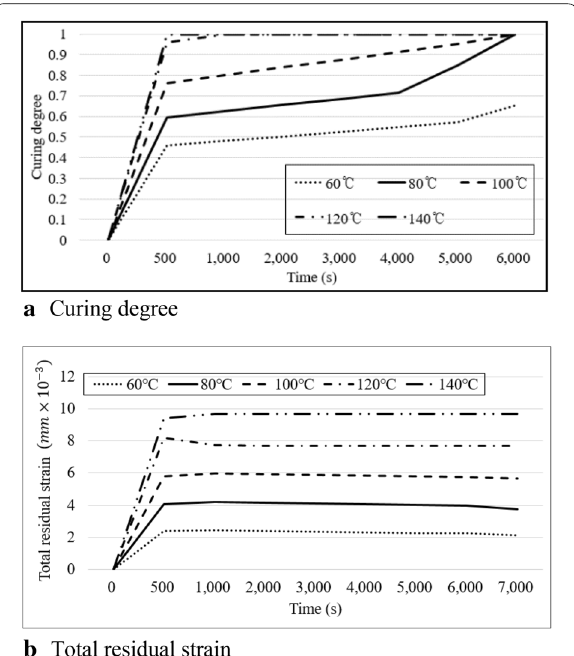
Figure 22 Results of curing analyses according to the temperatures of external heat